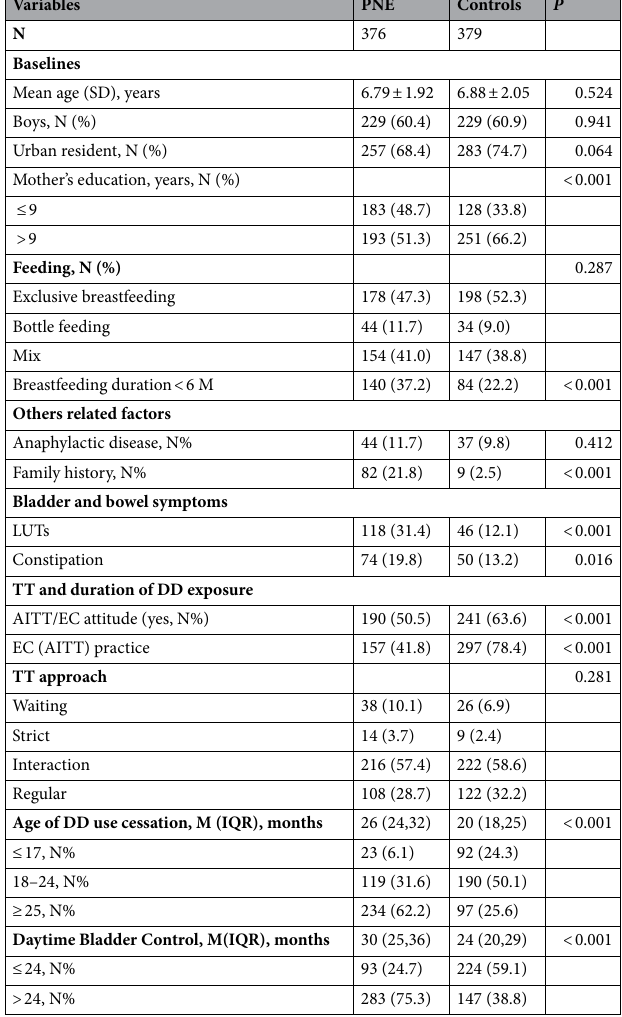
Table 1. Baseline and demographic characteristics of the study population. LUTS lower urinary tract symptoms, TT toilet training, AITT assisted infant toilet training, DD disposable diaper, M(IQR) median (interquartile